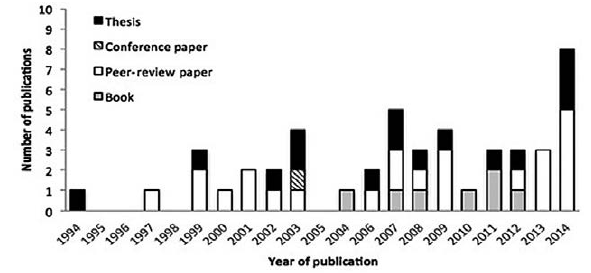
Fig. 1. – Numbers of publications highlighted in the literature search per year, separated by publication type. Note: one publication from 1976 was not included in the figure or analyses.